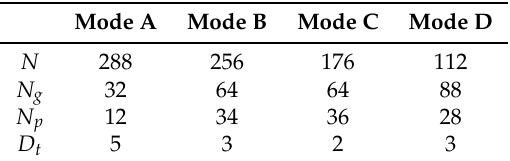
Table 1. Main parameters in Digital Radio Mondiale (DRM) modes.